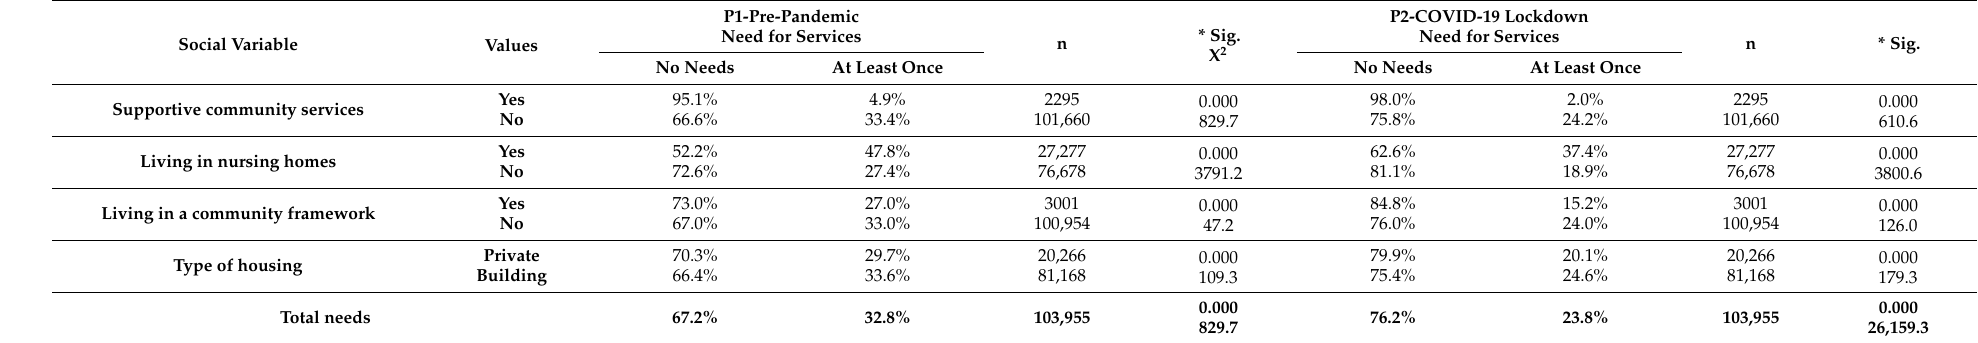
Table 2. Need for services pre-pandemic (P1) and in the COVID-19 lockdown period (P2) by social variables.